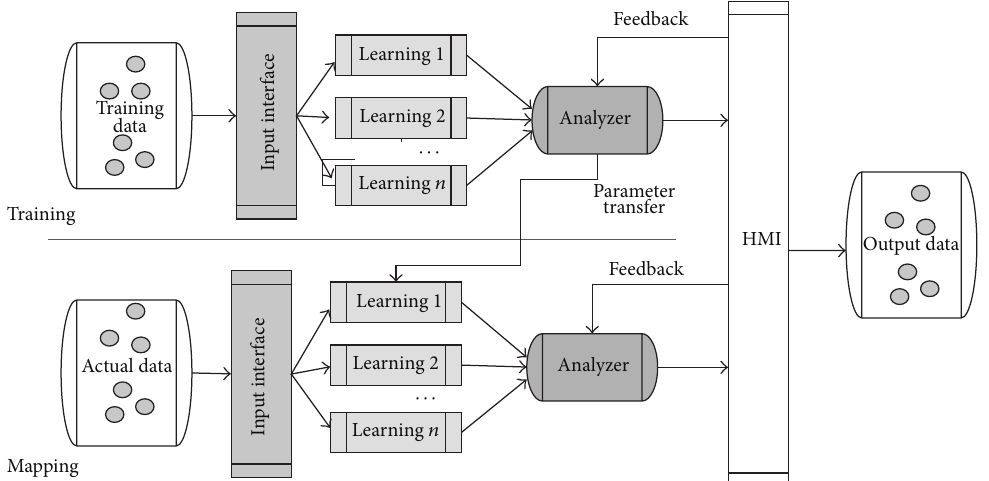
Figure 2: Flow diagram of automatic schema mapping of machine learning.